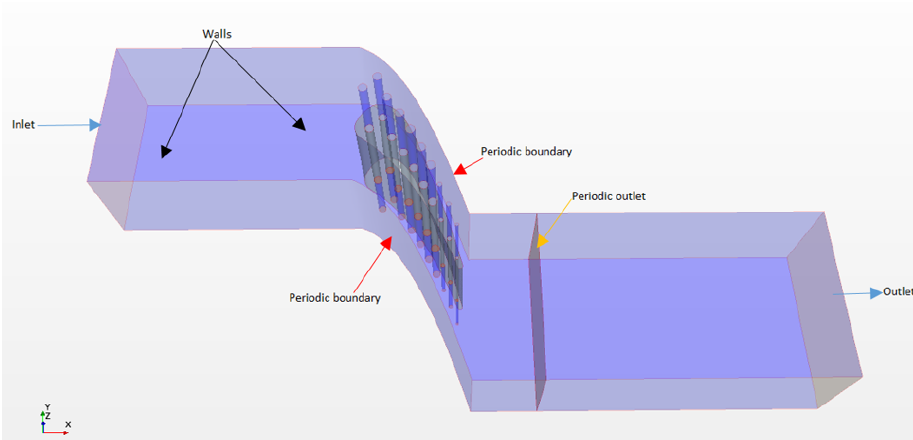
Figure 2. Computational